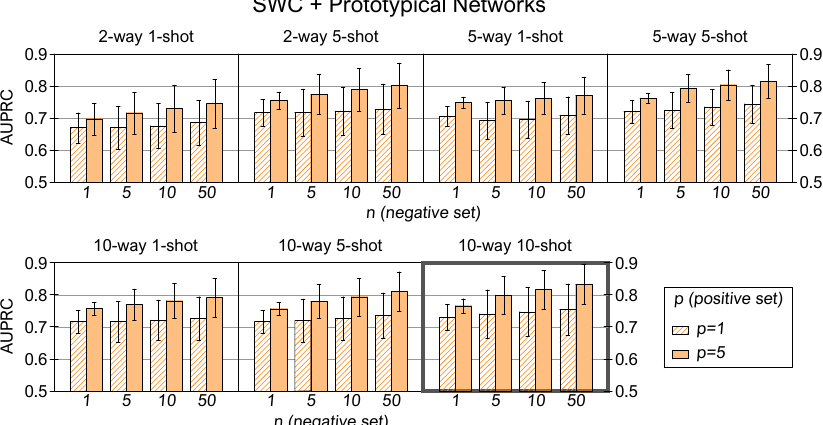
Figure 6. AUPRC results for prototypical networks trained and tested with SWC in several ( C , K , p , n ) combinations.